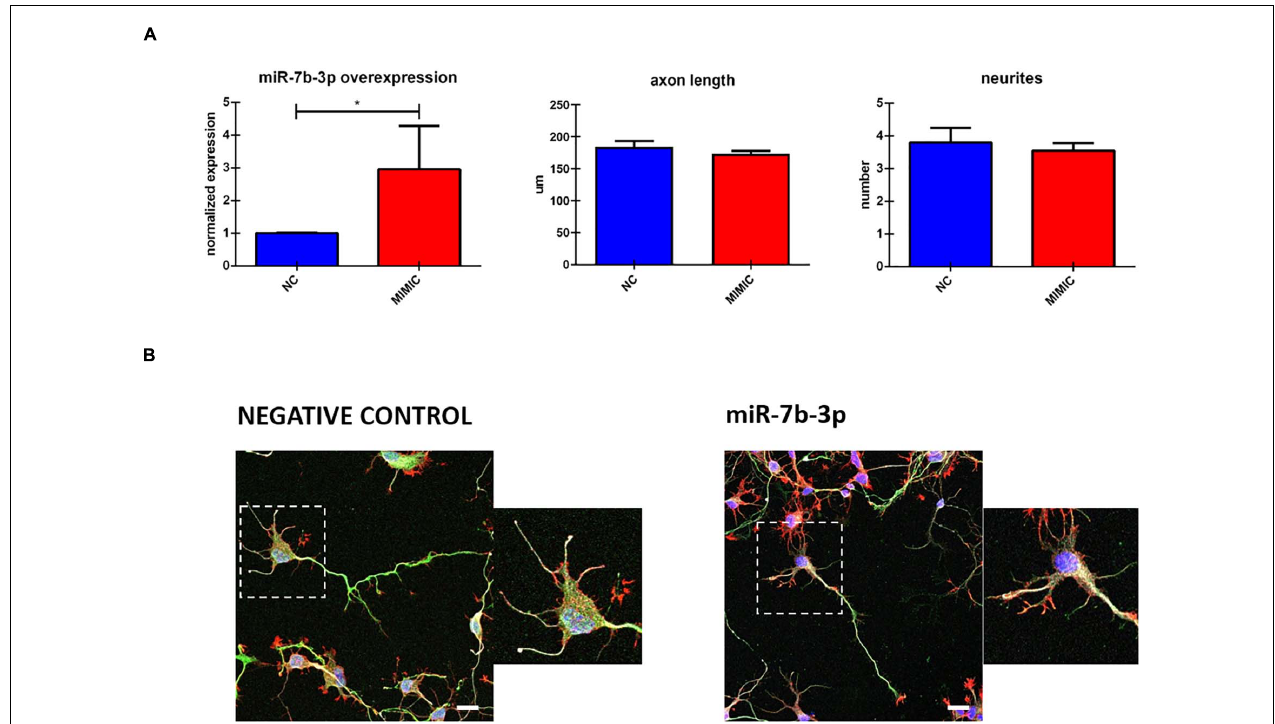
FIGURE 6 | miR-7b-3p overexpression and its role in neurite outgrowth. (A) miR-7b-3p overexpression and measurement of axon length ( n = 3) and number of dendrites ( n = 3). (B) Comparable axon length and number of dendrites in NC (negative control) and mimic-7b-3p electroporated cells. Scale bars: (B) , 20 µ m. The graphs express miRNA normalised relative expression value, µ m for axon length and number for neurites ± SEM ( t -test * p